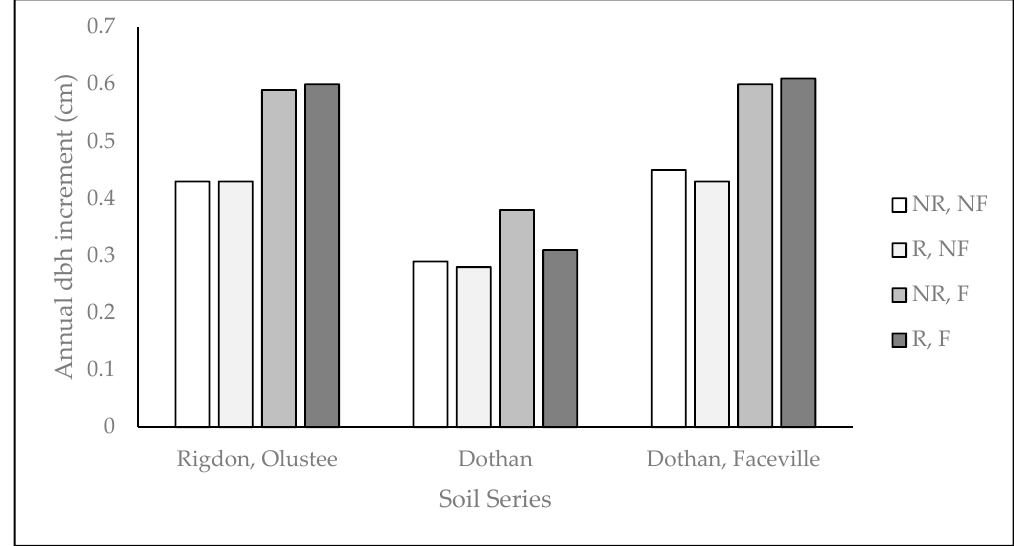
Figure 14. Loblolly pine mean annual dbh increment over the five-year study period by site [25]. Treatments: no rake, no fertilization (NR, NF); rake, no fertilization (R, NF); no rake, fertilization (NR, F); rake, fertilize (R, F) (refer to Tables 6 and 7 for study details, information on fertilizer treatments, and statistical test results).